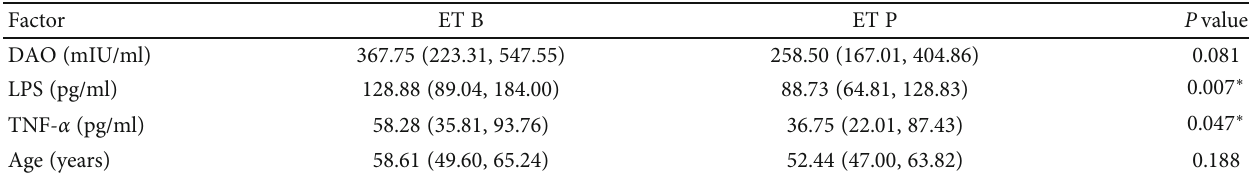
Table 3: Comparison of the four factors in the ET B and ET P.